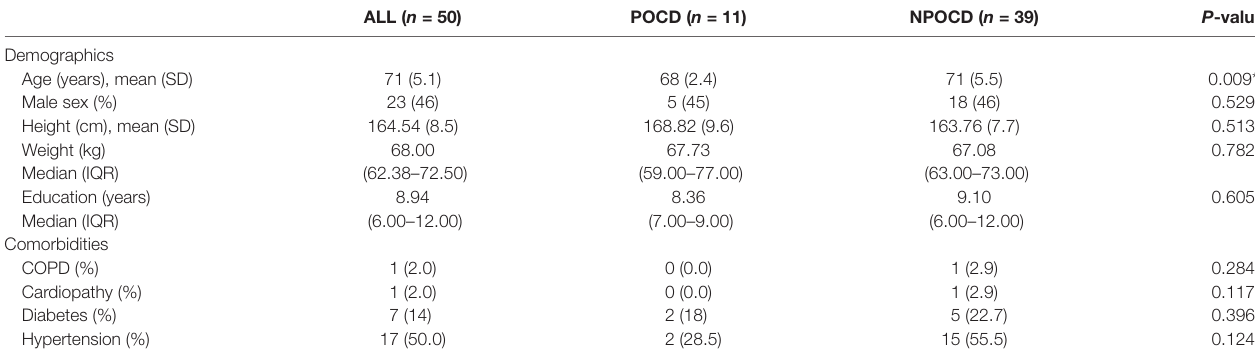
TABLE 1 | Demographics.